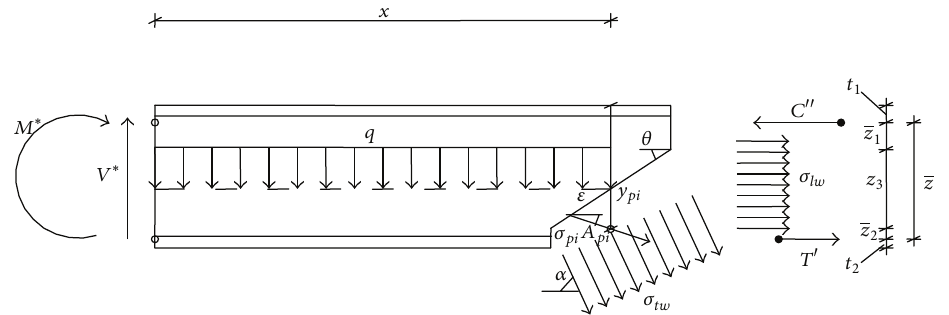
Figure 1: Beam segment with a cut parallel to the stress field of the web